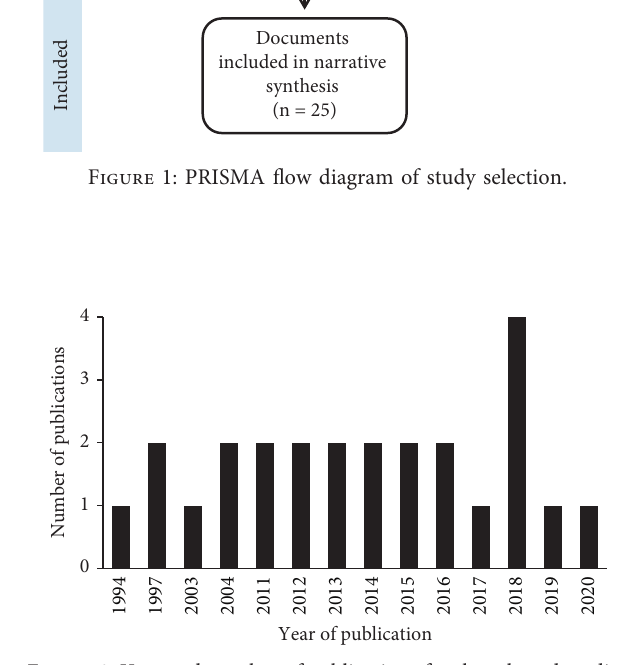
Figure 2: Year and number of publications for the selected studies ( n �